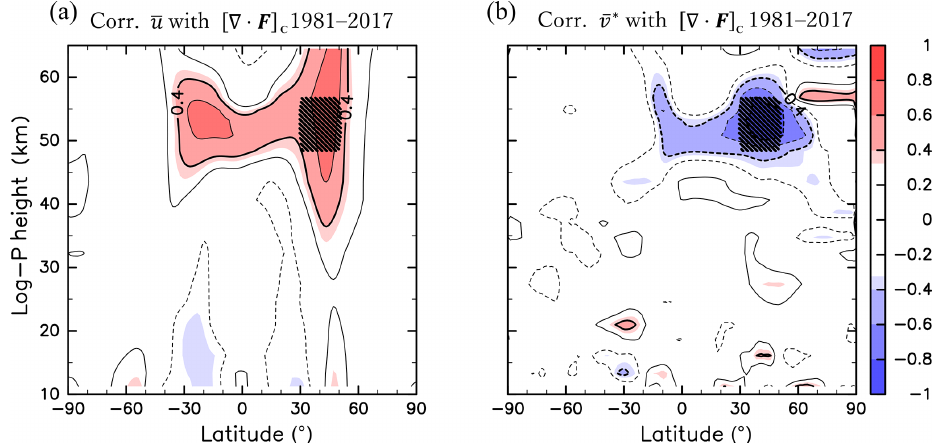
Figure 9. Same as Fig. 2 but for the correlations of [∇ · F ] C with (a) u (1981–2017) and (b) v ∗ (1981–2017) for DJF. Region C is indicated by